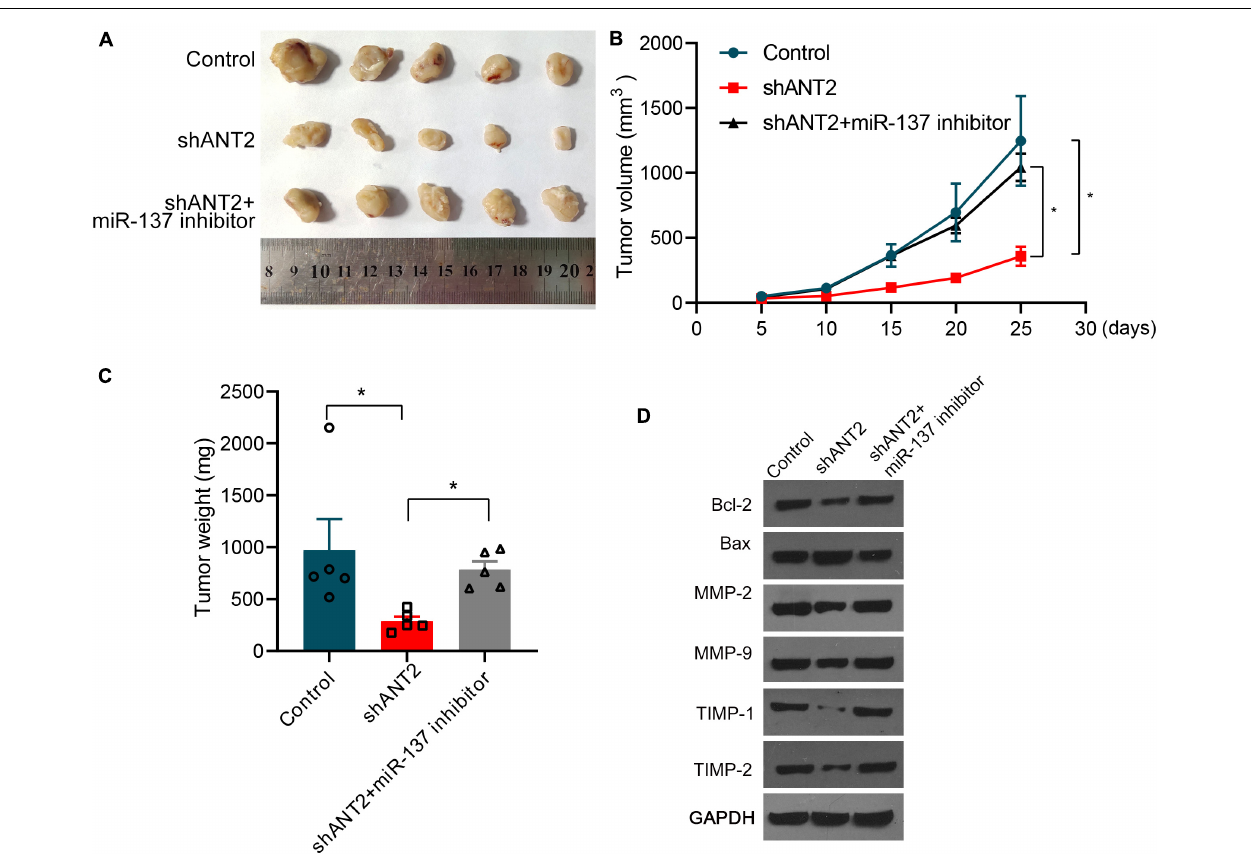
FIGURE 6 | miR-137 affects prostate cancer cell growth in vivo via ANT2. (A) shANT2 DU145 cell line and control cells were injected into the lower limbs of nude mice, and tumor tissues were dissected 1 month later. DU145 was significantly tumorigenic, but the amount of tumor tissue was significantly reduced following interference with ANT2; supplementation with miR-137 inhibitors counteracted the effect of shANT2. (B) Tumor volume and (C) tumor weight in each group. (D) Dissected tumor tissues were subjected to western blot analysis with the indicated antibodies. * p <